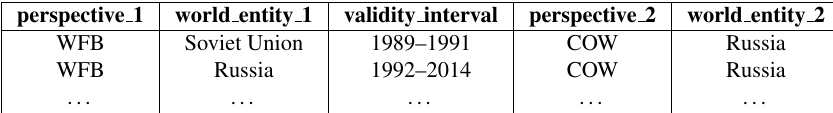
Table 3. Relations between world entities in different